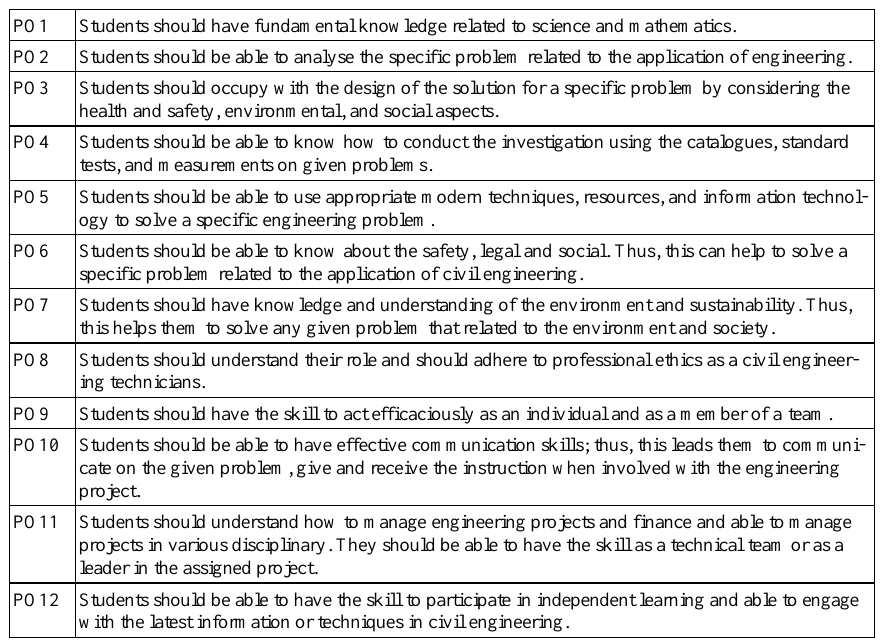
Table 1. Programme Outcomes (Pos) in the Engineering Technology Accreditation